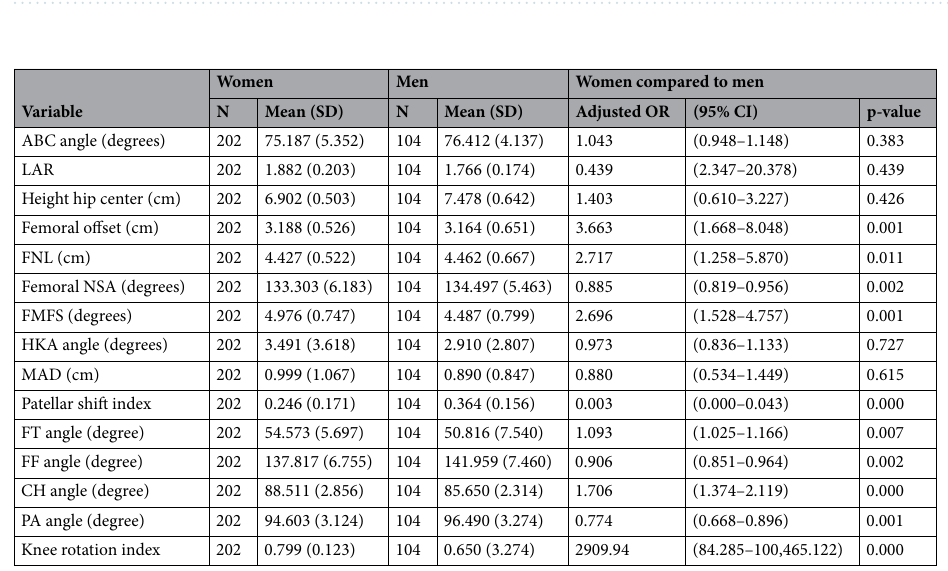
Table 2. Characteristics of the knee joints in the study.